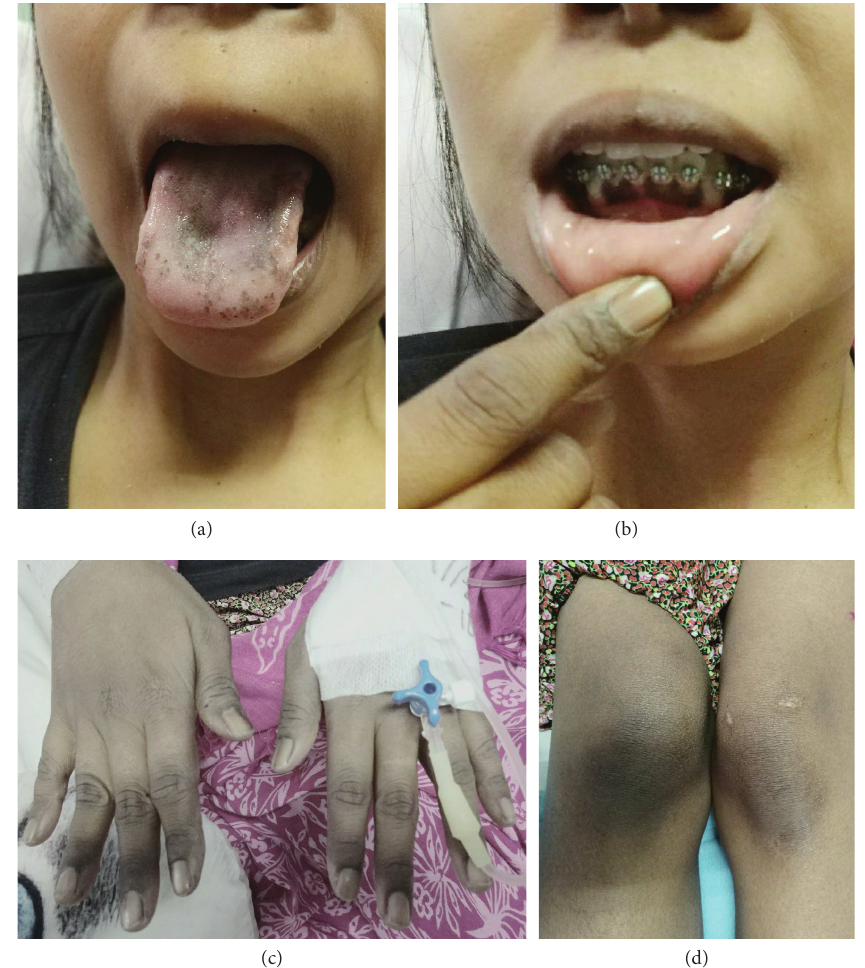
Figure 1: Hyperpigmentation on skin and mucosa: (a) tongue, (b) gum, (c) hands, and (d)